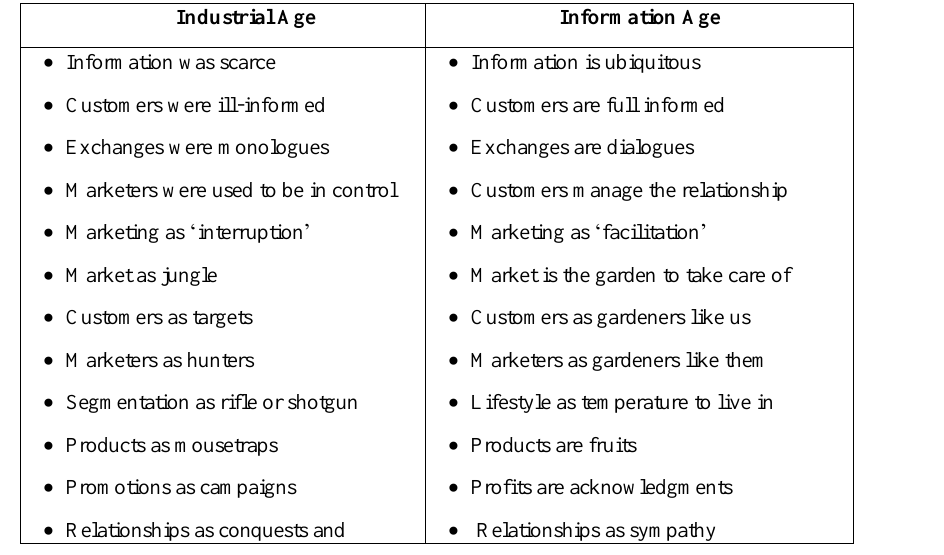
Table 1: Strategic Drivers from Industrial to Information